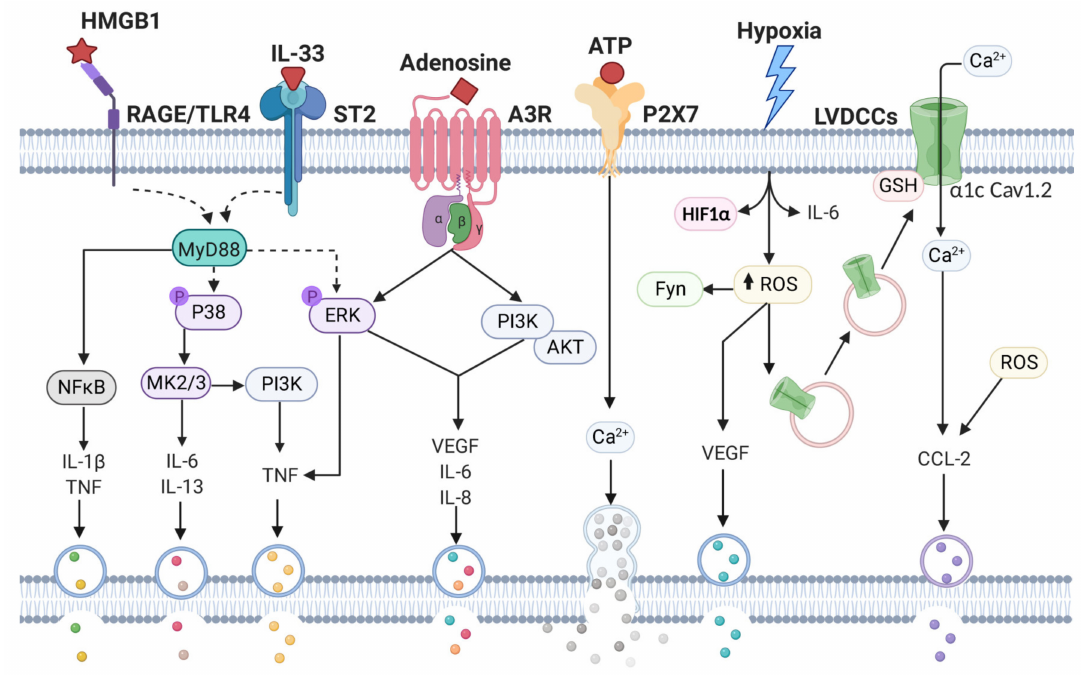
Figure 4. Molecular events involved in the response of MCs to mediators produced by cell damage and stress. HMGB1, IL-33, adenosine and ATP are the best-characterized alarmins able to activate MCs after tissue damage. Together with hypoxic microenvironment, those signals activate distinct signaling pathways leading to cytokine production in MCs. Binding of HMGB1 to RAGE leads to the activation of the MyD88-dependent signaling pathway leading to NF κ B transcription factor and promotes the production of TNF and IL-1 β . IL-33 activates ST2 receptor and also triggers the MyD88-dependent signaling pathway. Downstream e ff ectors of MyD88 (MK2 / 3) are essential for the secretion of IL-6 and IL-13. In addition, IL-33 favors the production of TNF with the participation of ERK and PI3K. ATP activates P2X7 purinoreceptors and induces calcium influx with the consequent degranulation. Activation of adenosine A3 receptor by adenosine triggers ERK and PI3K and promotes the production of inflammatory and angiogenic mediators. Hypoxia leads to the stabilization of HIF1 α , production of ROS and Fyn -dependent VEGF and IL-6 secretion. ROS production promotes the glutathionylation (GSH) and translocation of the α 1c subunit of Cav1.2 L-type voltage-dependent Ca 2 + channels (LVDCCs) from intracellular pools to plasma membrane. ROS and calcium entry promote the accumulation of CCL2 mRNA to, finally, induce the secretion of that chemokine. Stimulation pathways are represented with solid lines, whereas putative pathways are shown in dashed lines. Created with